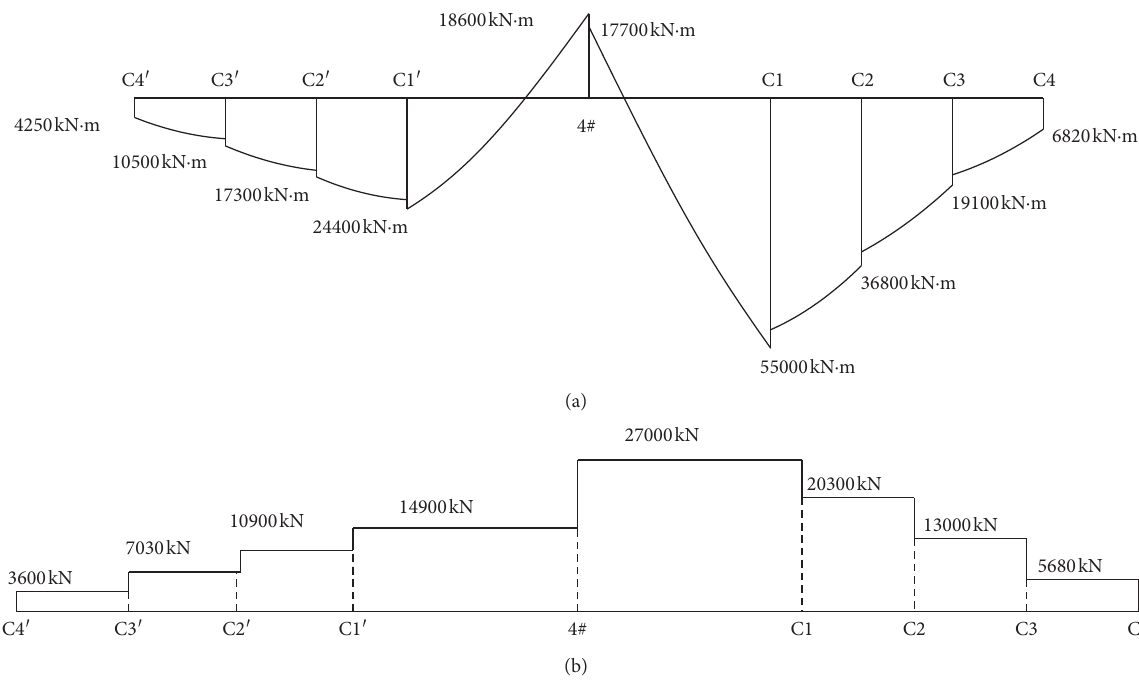
Figure 15: Internal force of main girder on Pier 4# (Condition 1). (a) Moment diagram. (b) Axial force